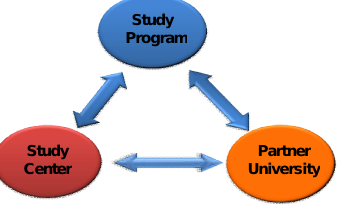
Figure 2. Practicum components in distance